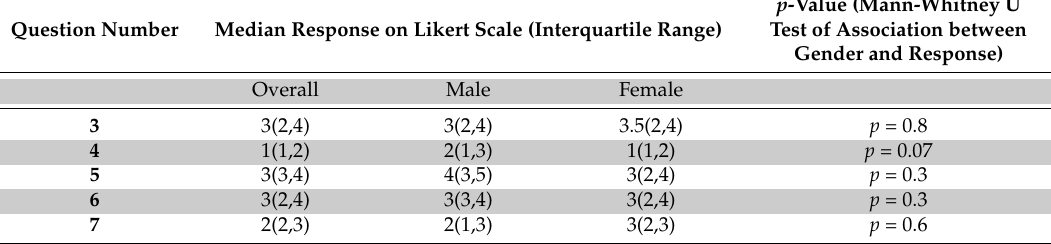
Table 2. Participants’ responses to Question 8: “Ideally, how should clinicians and patients arrive at the optimal treatment option for the edentulous